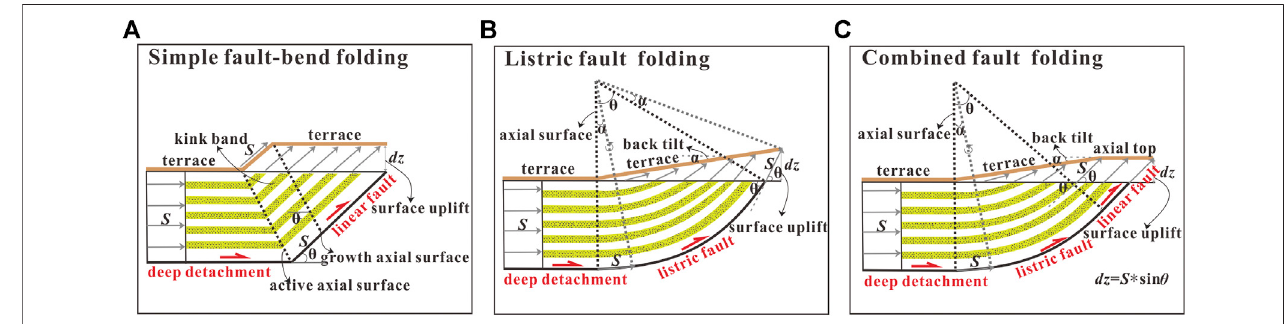
FIGURE 6 | Kinematic models of different reverse fault-related folds. (A) Simple fault-bend folding (modi fi ed from Suppe, 1983; Suppe et al., 1992, Suppe et al., 1997; Erslev, 1991; Medwedeff and Suppe, 1997): the fault grows linearly, the surface deformation is uniform within each dip domain de fi ned by a planar fault, and the backlimbisshortandrelativelysteep. (B) Listricfaultfolding(modi fi edfromAmosetal.,2007;Charreauetal.,2008):thefaultgrowslistricallybylimbrotation,thesurface deformation is sequential and nonuniform, and the backlimb is long and fl atter with no axial top. (C) Combined fault folding (modi fi ed from wang et al., 2020b, Trexler et al., 2020): the fault grows listrically and then connects to a linear segment and dips at a constant angle to the surface. The surface deformation is similar to the listricfaultbutwithanaxialtop.(Inallthreemodels,weassumethereisnotiltinthesubstratawhilethesurfaceabovethefaultisundeformed,andthedeepfaultisinitially developed from a subhorizontal detachment structure.)